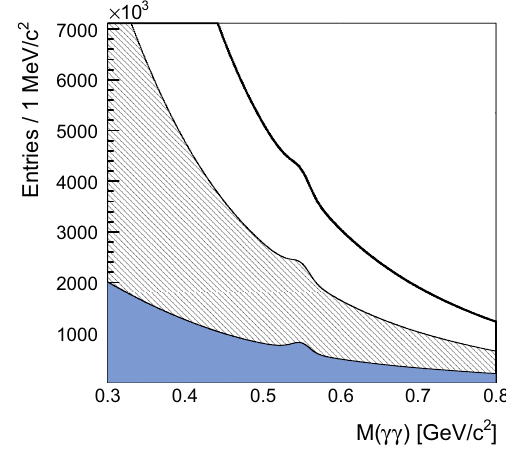
Fig. 2 Two photon invariant mass at different stages of the η selection, fromthe Υ ( 5 S ) collisondata:beforetheselection(blacksolid),afterthe photon selection (black hatched), and after all the selections, including the π 0 veto (blue solid)